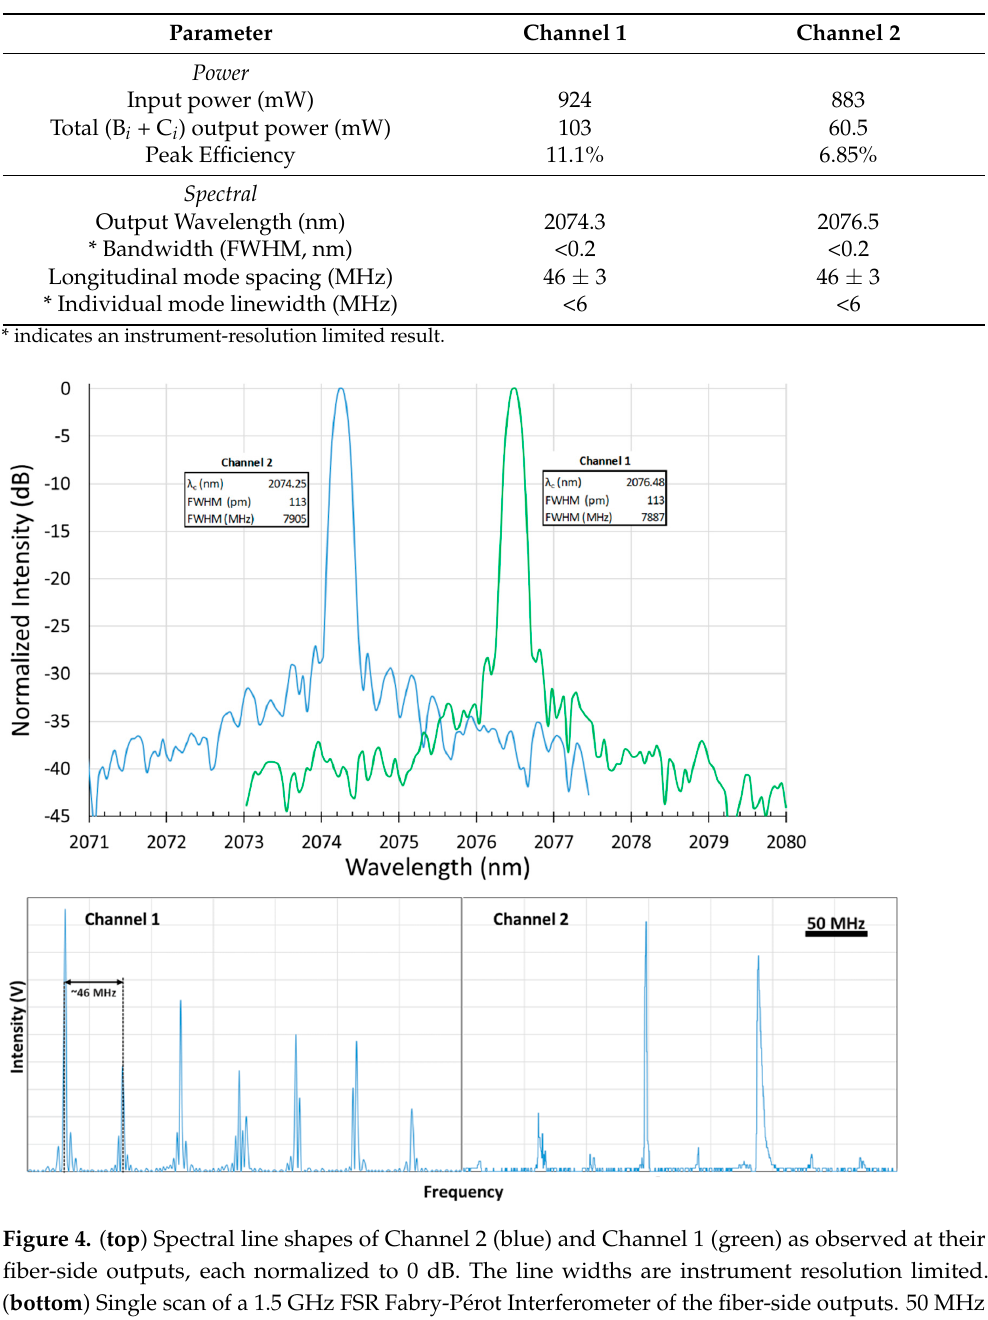
Table 3. Experimental parameters associated with each laser channel.